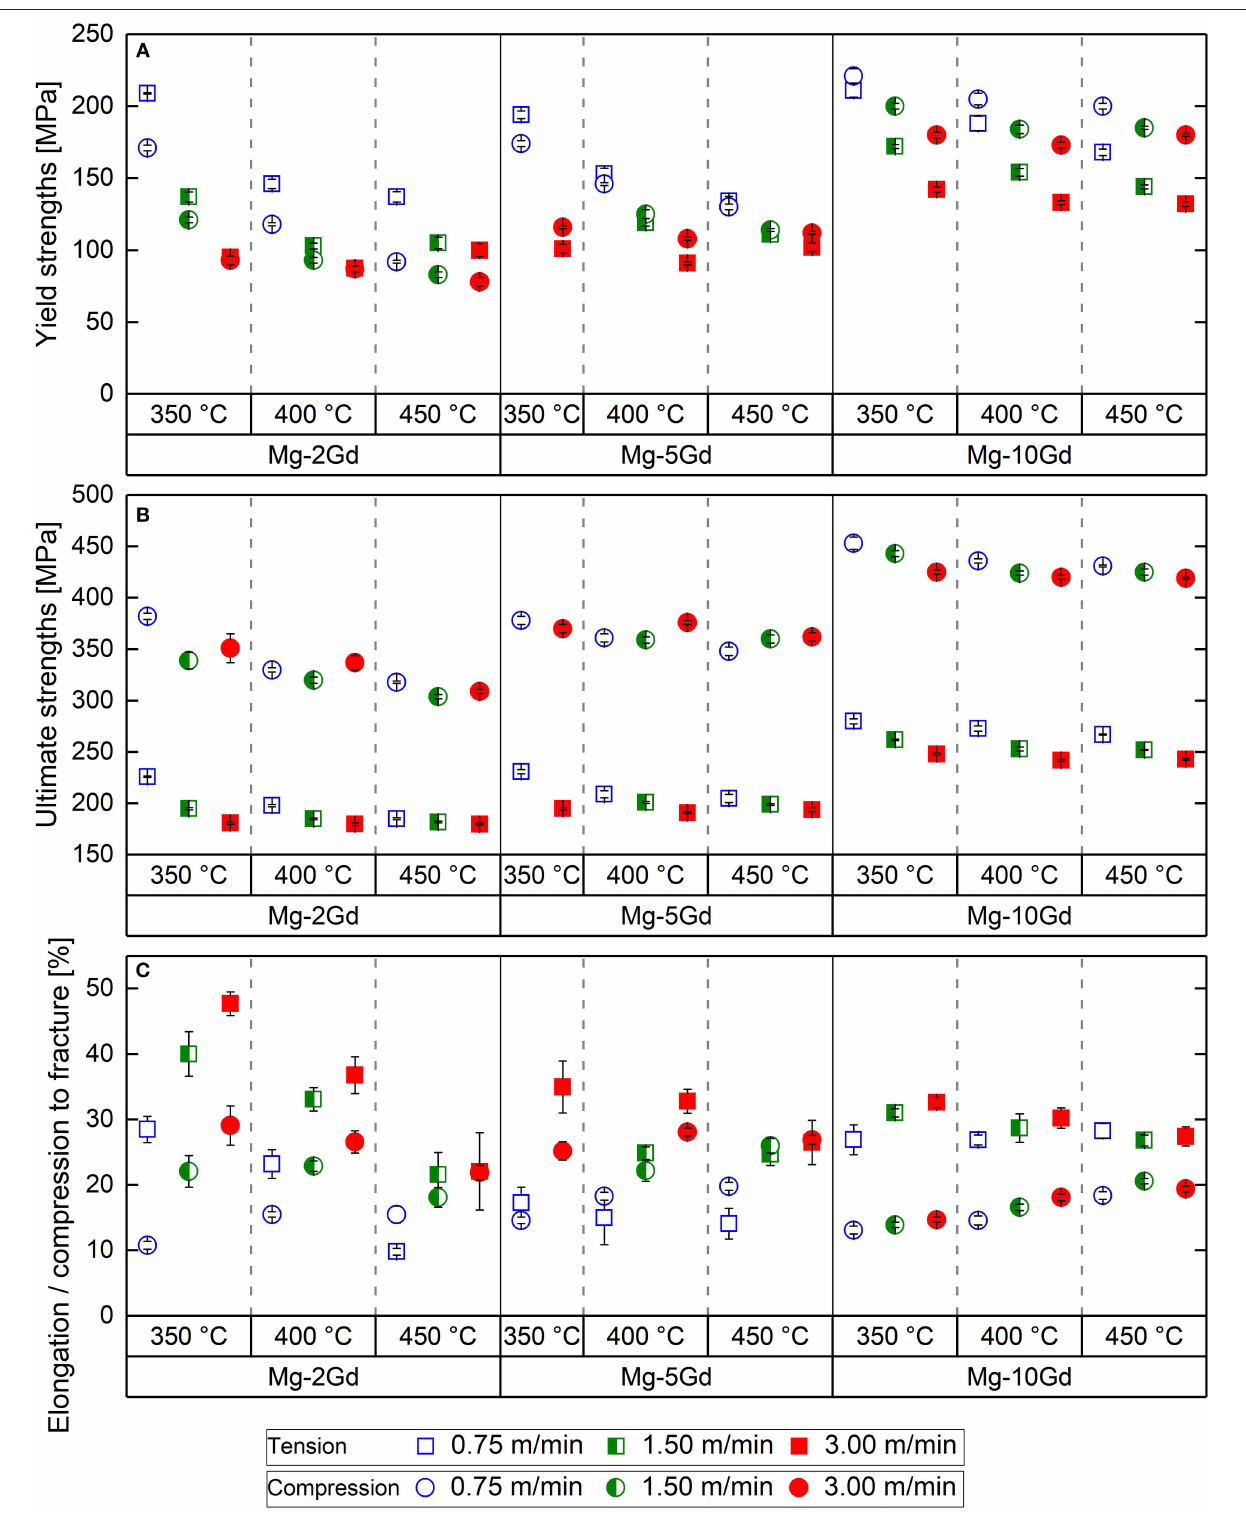
Frontiers in Materials |